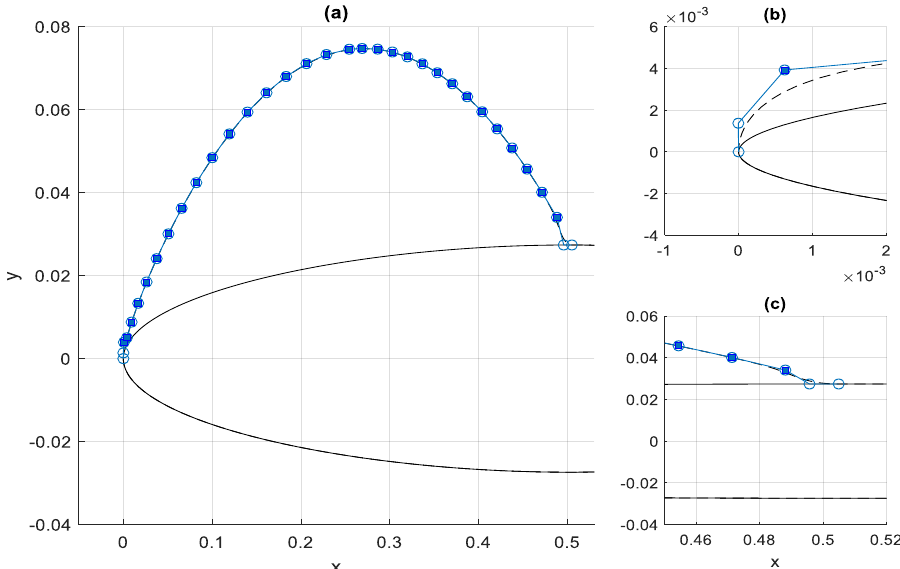
Figure 2. ( a ) Attached cavity parametrization using B–splines, with details about ( b ) the cavity Figure 2. Attached cavity parametrization using B – splines with details about the cavity de- detachment area and ( c ) the termination point tachment and termination points (b),(c).